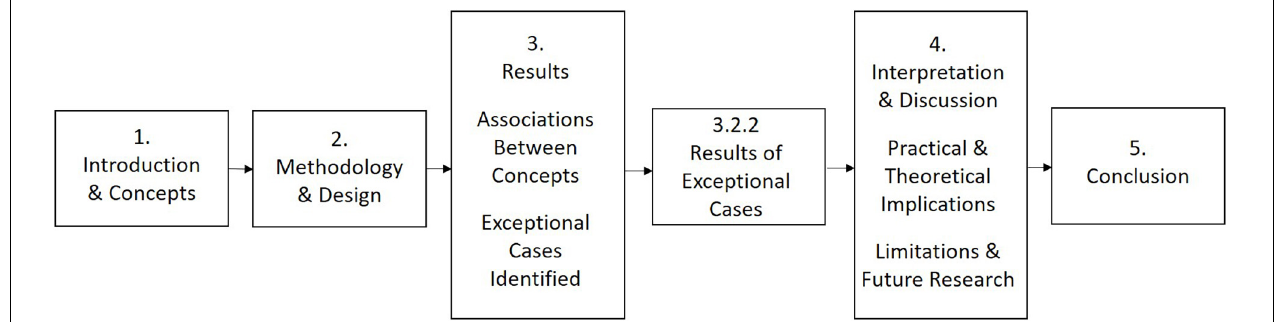
FIGURE 1 | Flow chart of the present study.